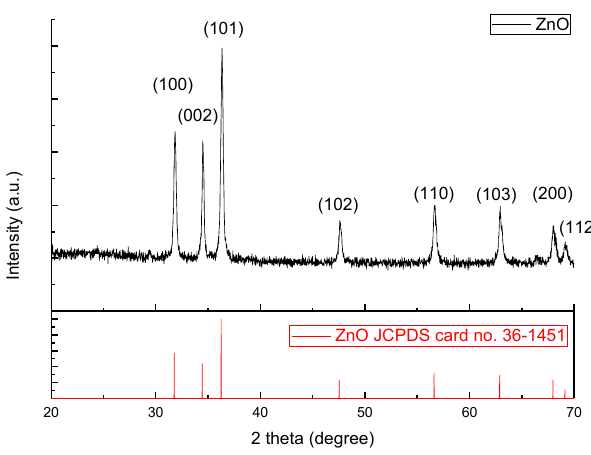
Figure 2. X-ray diffraction (XRD) pattern of the as-synthesized zinc oxide (ZnO) nanorod powder.